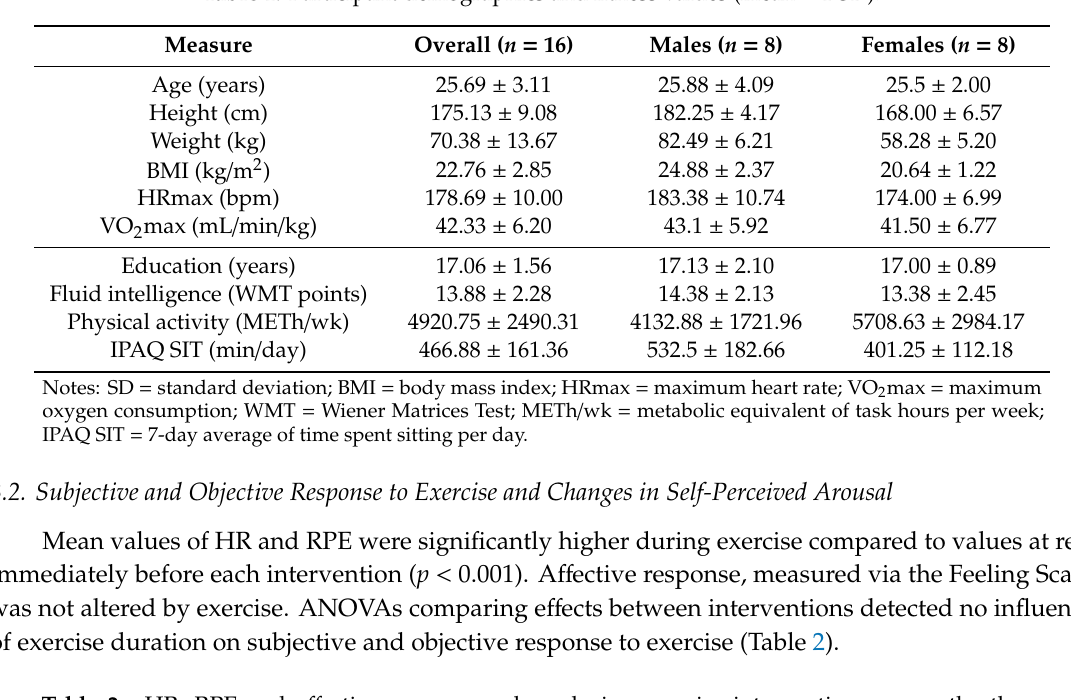
Table 2. HR, RPE and a ff ective response values during exercise interventions across the three experimental sessions and baseline CPET (mean ± 1